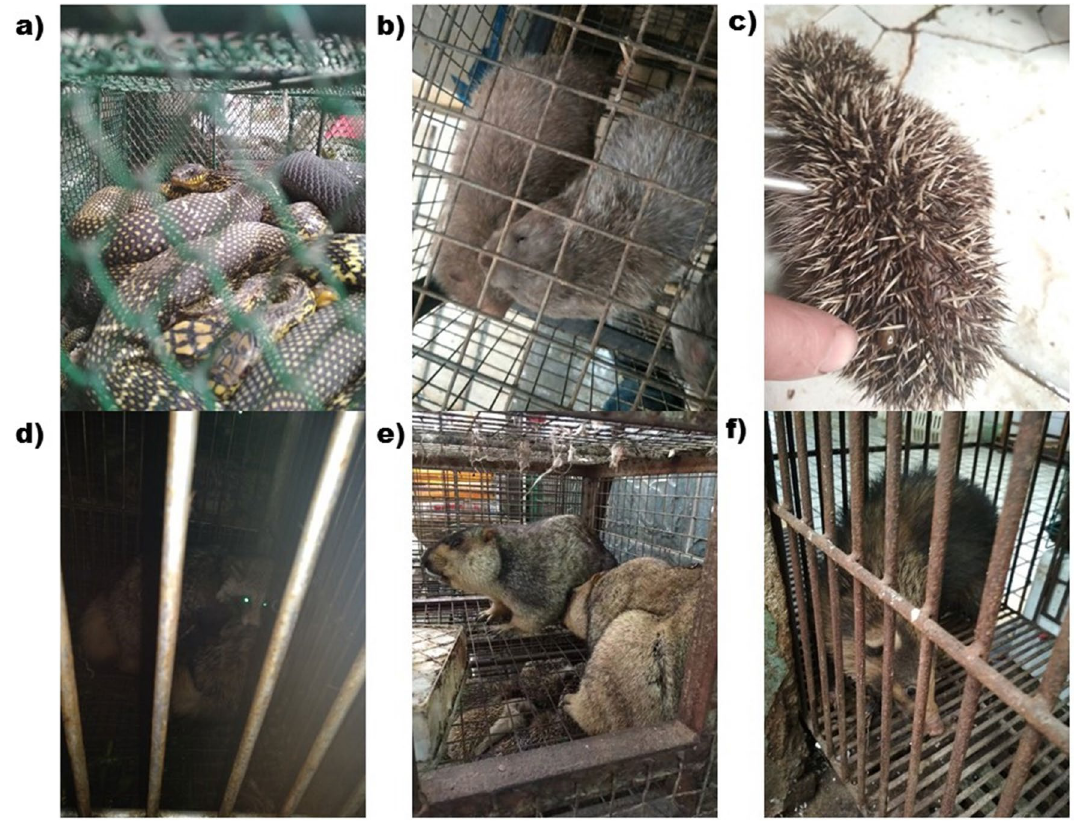
Figure 2. Poor welfare of animals on sale in Huanan seafood market: ( a ) King rat snake ( Elaphe carinata ), ( b ) Chinese bamboo rat ( Rhizomys sinensis ), ( c ) Amur hedgehog ( Erinaceus amurensis ) (the finger points to a tick), ( d ) Raccoon dog ( Nyctereutes procyonoides ), ( e ) Marmot ( Marmota himalayana ) (beneath the marmots is a cage containing hedgehogs), and ( f ) Hog badger ( Arctonyx albogularis